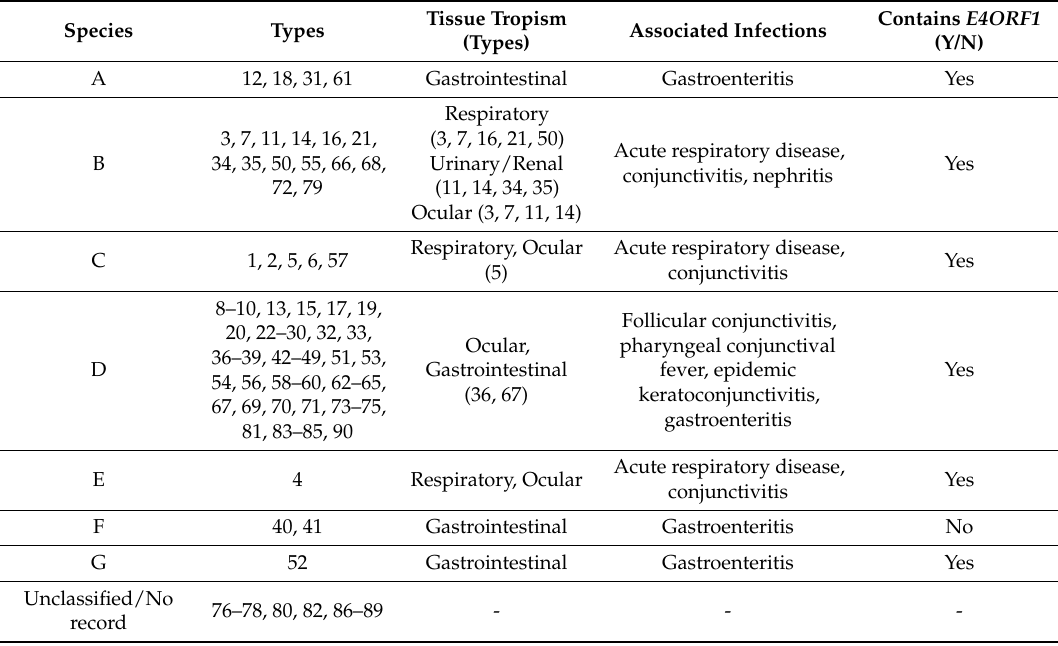
Table 1. Different HAdV species and associated types, tissue tropisms and clinically associated infections. The last column indicates whether the species contains the metabolism-associated E4ORF1 viral